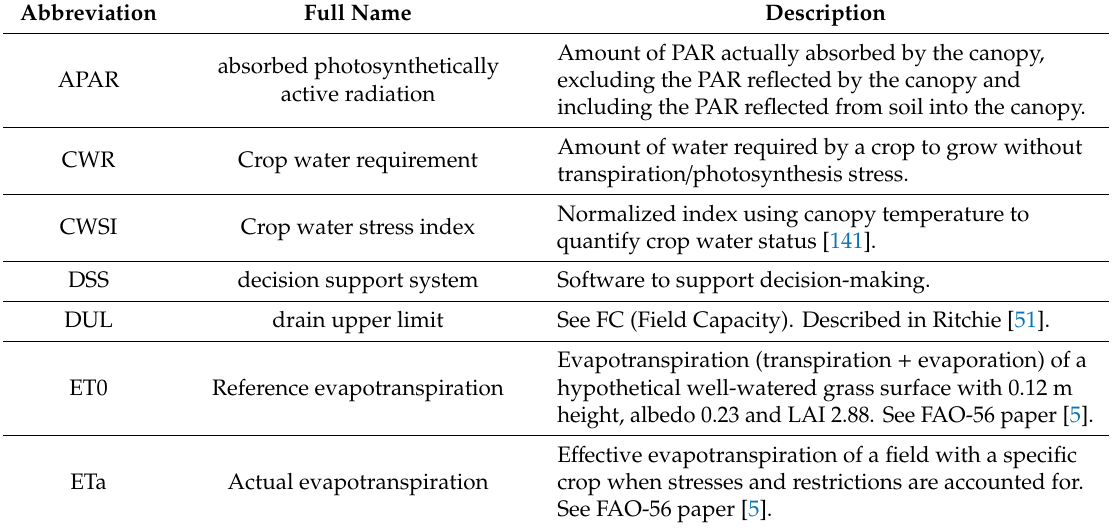
Table A1. Glossary of abbreviations and recurrent terms used in the